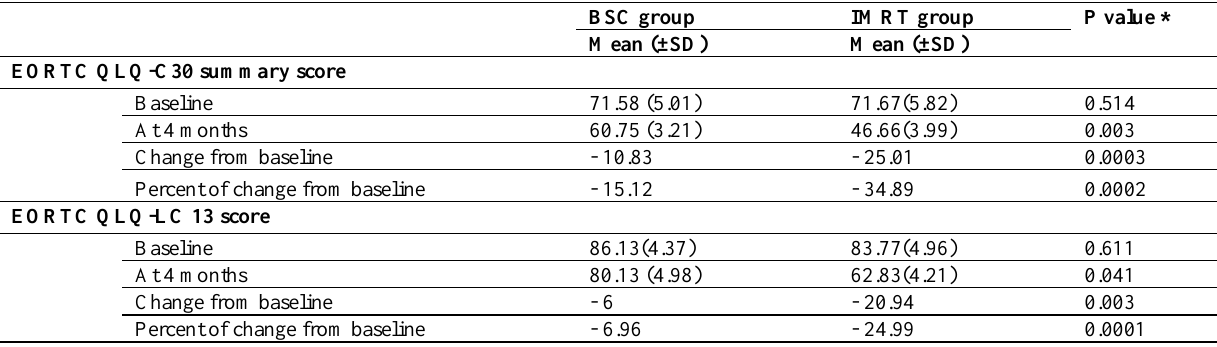
Table 3. EORTC QLQ-C30 summary score and QLQ-LC13 score in both groups